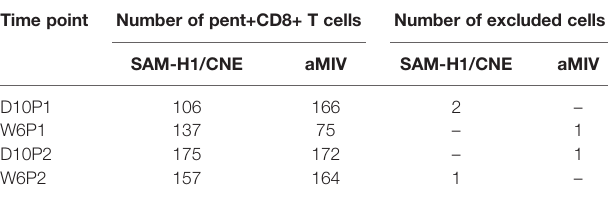
TABLE 1 | Number of pent+CD8+ T cells derived from a pool of two spleens from each immunization groups and at each timepoint pro fi led by RT-qPCR. Time point Number of pent+CD8+ T